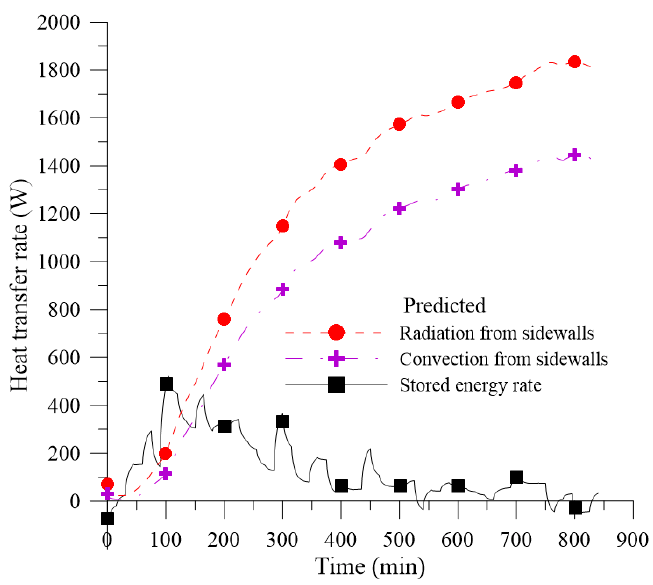
Figure 24. Radiation heat transfer coefficients for the kiln with and without thermal insulation as a function of time.